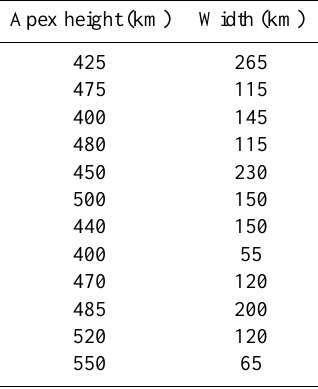
Table 2. Apex height and width of selected